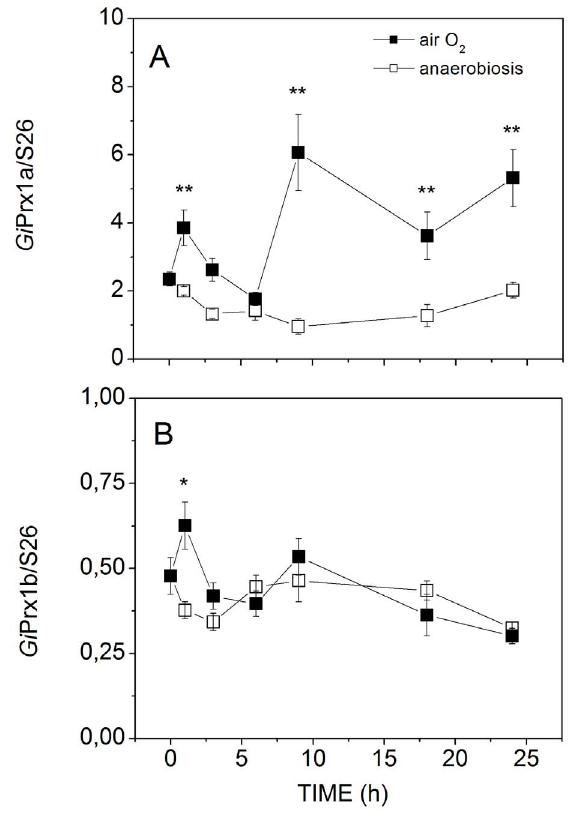
Figure 6. Effect of O 2 on the transcriptional levels of Gi Prxs. Expression level of the genes coding for Gi Prx1a (A) and Gi Prx1b (B), evaluated by qPCR as a function of the incubation time of trophozoites with air O 2 (closed symbols) or under anaerobic conditions (open symbols). Data (mean 6 1 SEM, n $ 3) were normalized to the mRNA level of the housekeeping ribosomal small subunit protein S26 (ORF 17364). *P , 0.05 and **P , 0.01 (aerobic vs anaerobic conditions at the same incubation time).